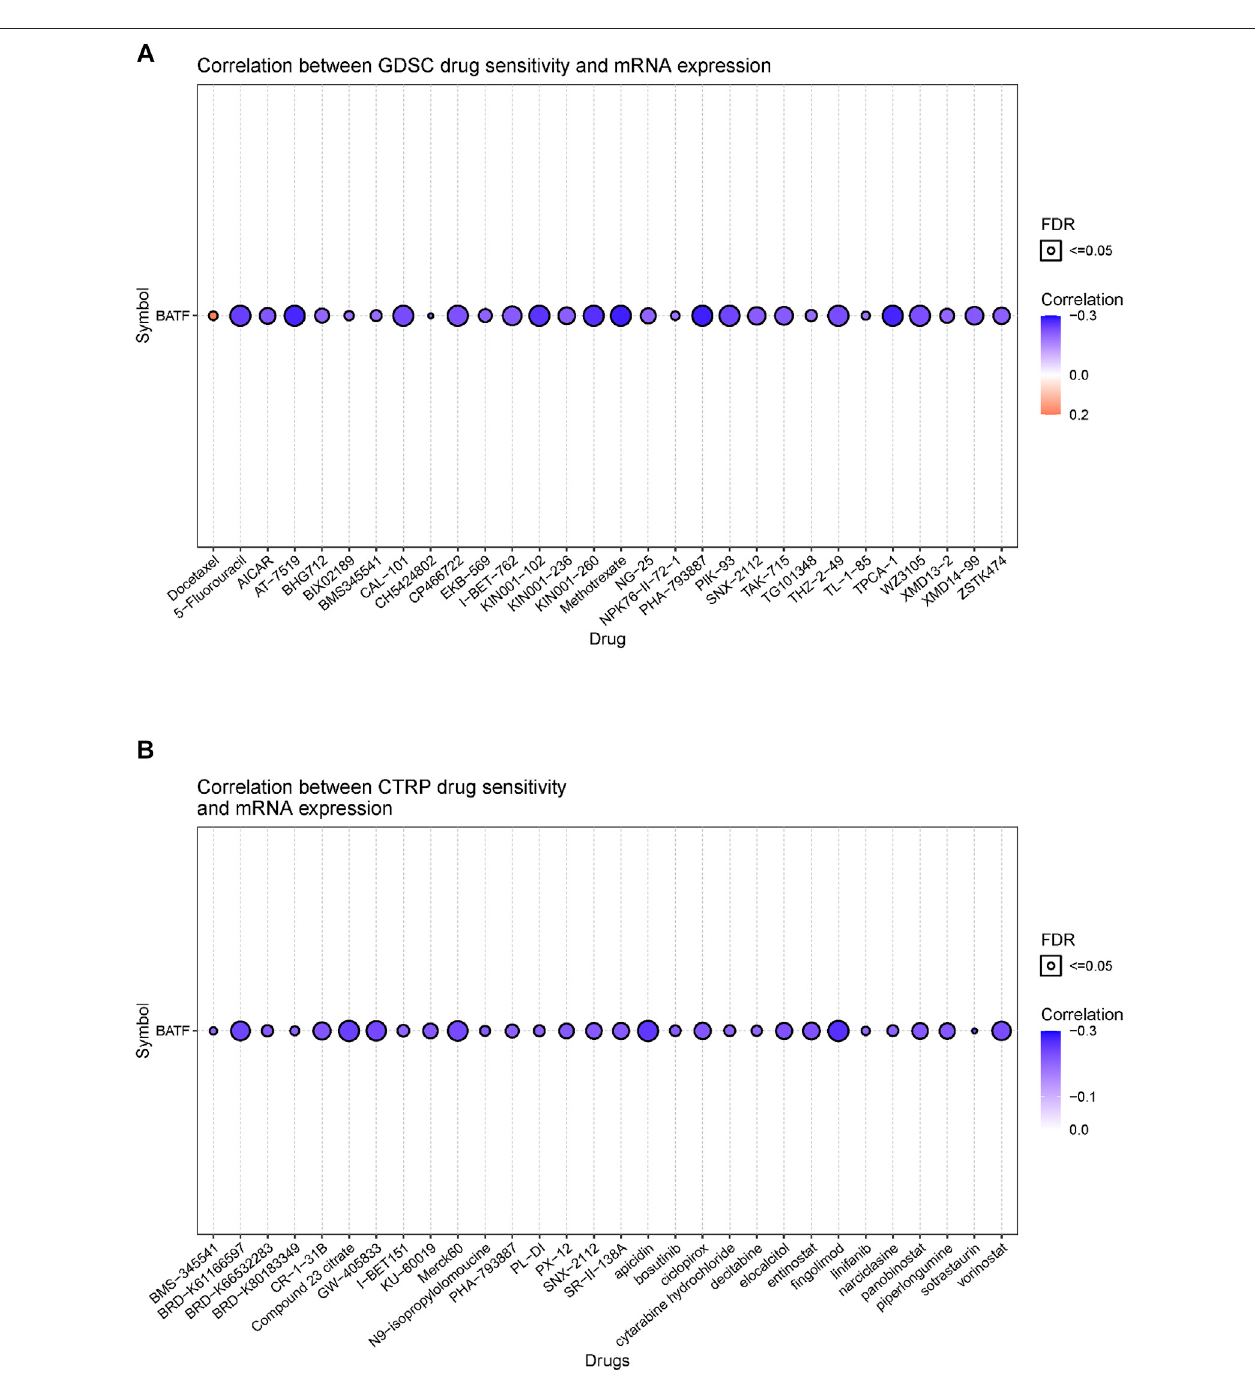
FIGURE 10 | Correlation between FDA-approved drug sensitivity and BATF expression. (A) Correlation between GDSC drug sensitivity and BATF expression. (B) Correlation between CTRP drug sensitivity and BATF expression.